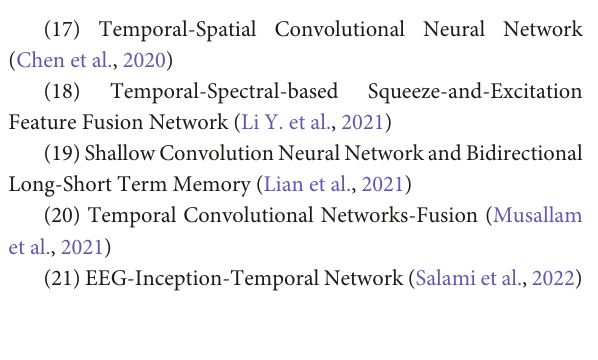
Our algorithm, which we term Sequential Backward Selection with Temporal Filter Bank Common Spatial Patterns (SBS-TFBCSP), significantly outperformed the average performance (79.99% ± 2.23; mean ± std) of all other algorithms. By 12.61% ( T (8) = 5.057, p < 0.001; t -test; Table 1 ) and outperformed each of those algorithms individually. The algorithm outperformed the contender leading algorithm (DCR-MEMD) by 4.94%, yet this was not significant ( T (8) = 1.322, p = 0.223, t -test). While